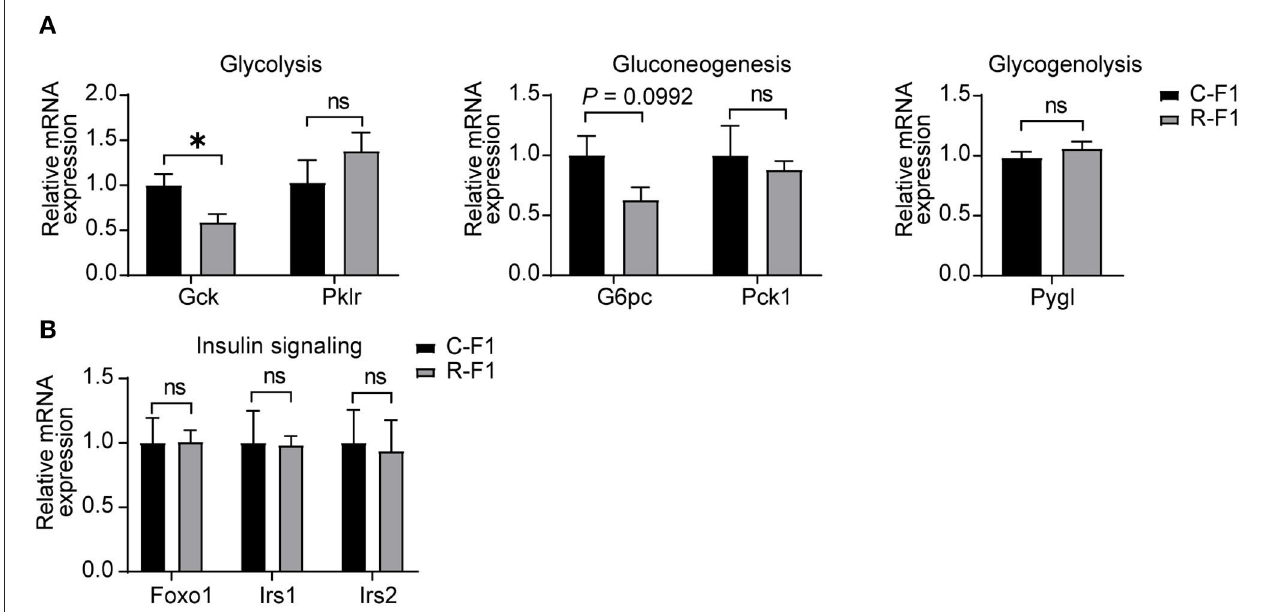
FIGURE 7 | Disturbance ofliver glucose metabolism-associated gene expression in the male F1 mice of the exposed father. (A) Relative mRNA levels of glycolytic (Gck and Pklr), gluconeogenic genes (G6pc and Pck1), and glycogenolytic gene (Pygl) in livers of each group. (B) Gene expression of insulin signaling between male F1 mice. ns, not significant. (A,B) C-F1, F1of the control father; R-F1, F1 of the Radiation father. * p < 0.05. n = 6 for each group. Student’s t